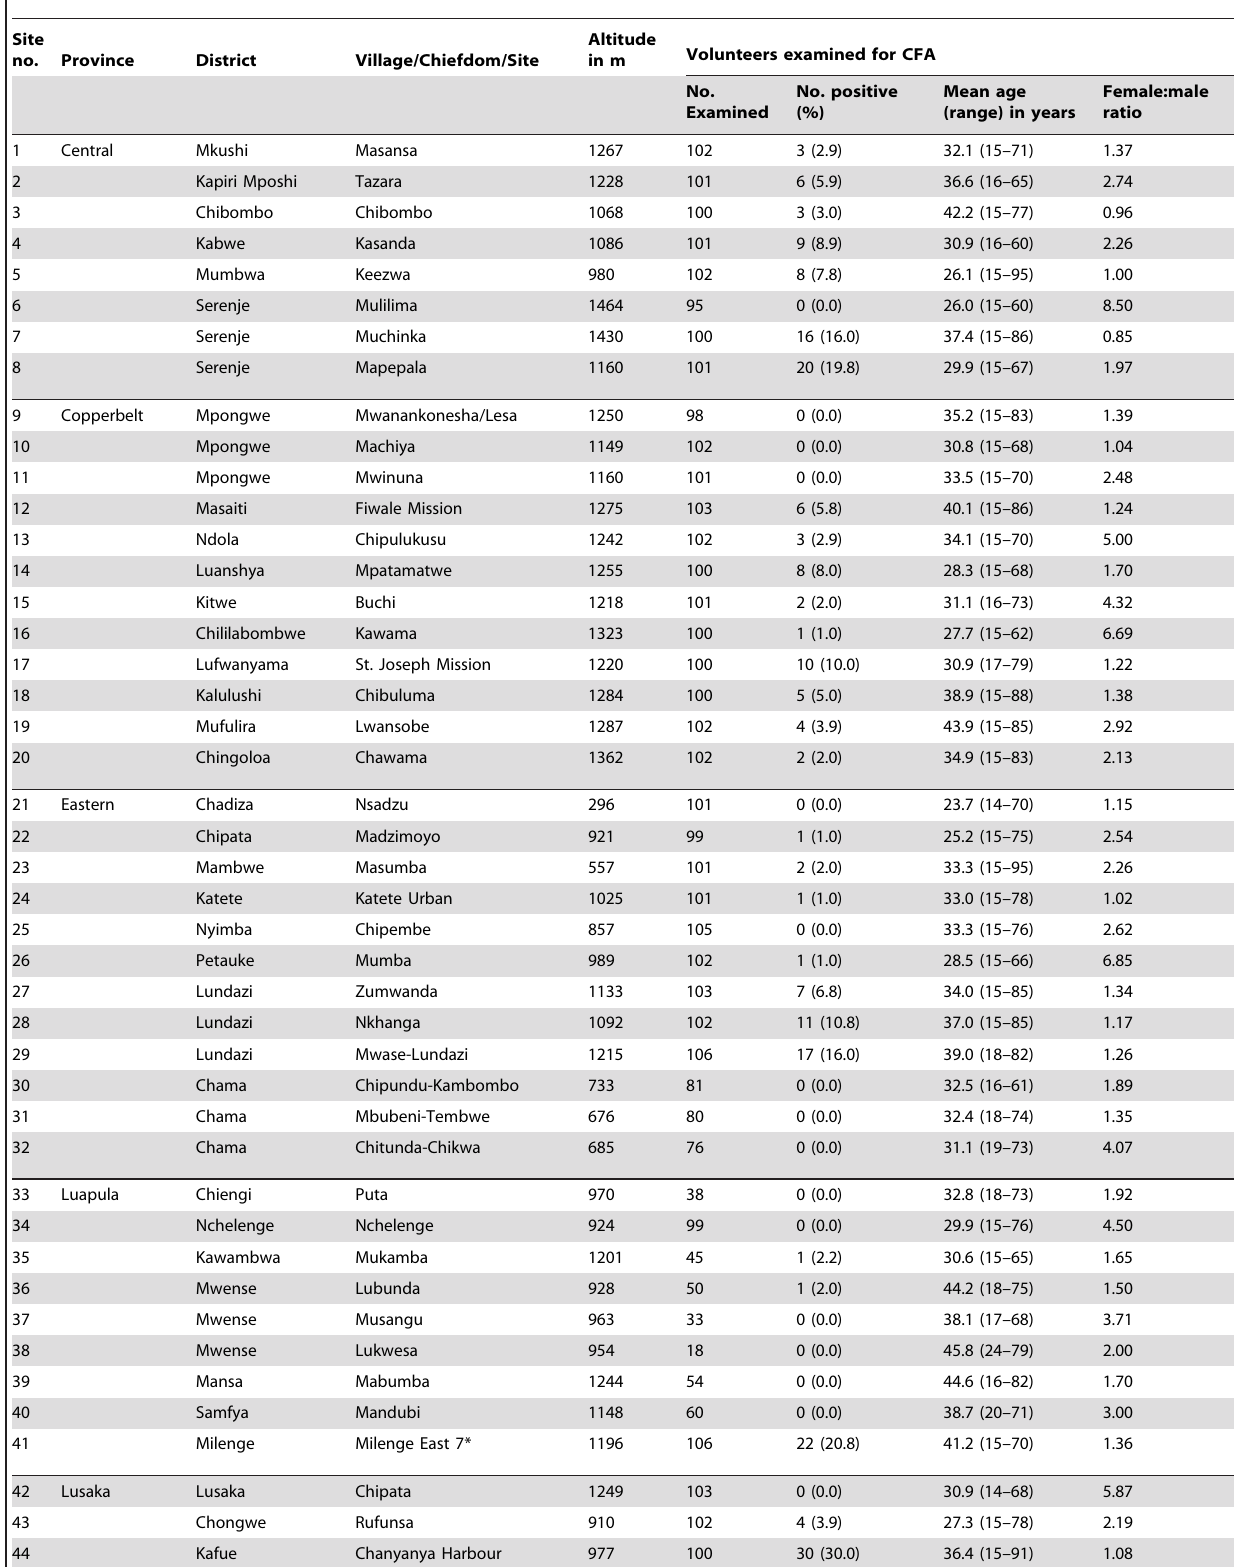
Table 2. Overview of study sites, and the numbers, positivity for circulating filarial antigens (CFA), ages and gender ratios of examined